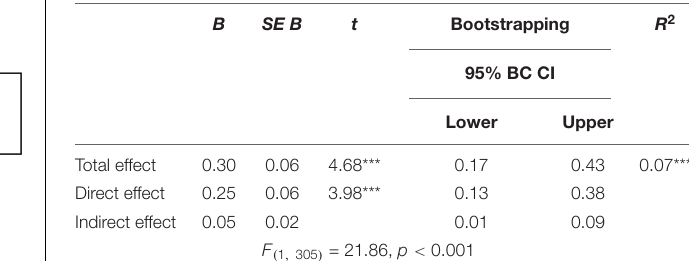
TABLE 4 | Total, direct, and indirect effect of health-promoting collaboration and presenteeism on work